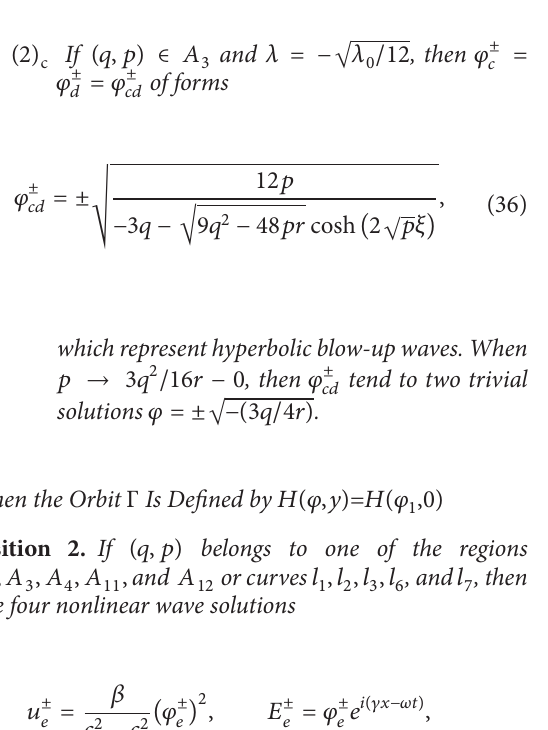
Figure 3: (The 2-blow-up waves are bifurcated from the periodic-blow-up waves.) The varying process for the figures of 𝜑 ± 𝑏 when (𝑞,𝑝) ∈ 𝐴 2 and 𝑝 → 0 − 0 , where 𝑟 = 1 , 𝑞 = −4 and (a) 𝑝 = 0 − 1 , (b) 𝑝 = 0 − 0.5 , (c) 𝑝 = 0 − 0.1 , and (d) 𝑝 = 0 − 0.01